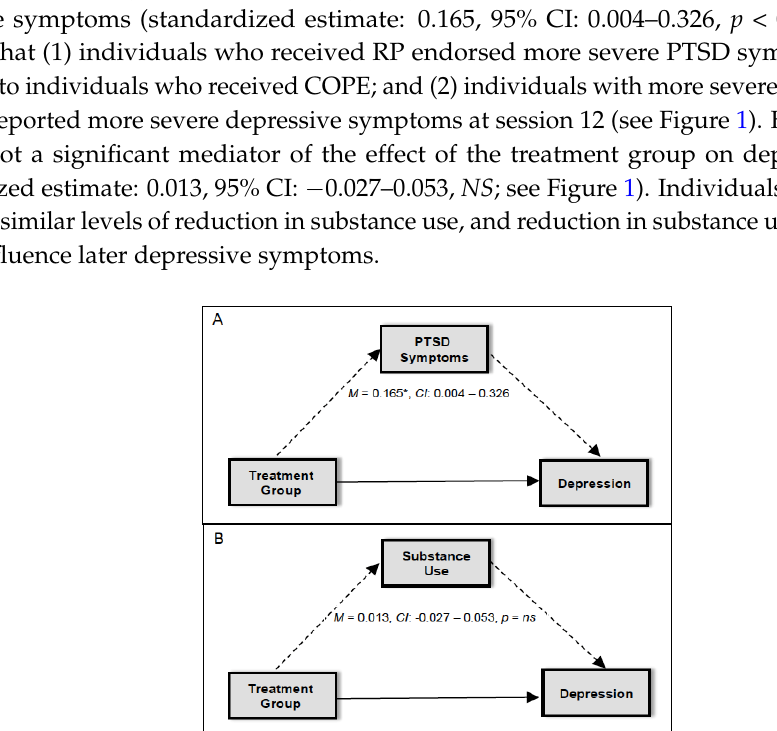
Table 2. Standardized model results.